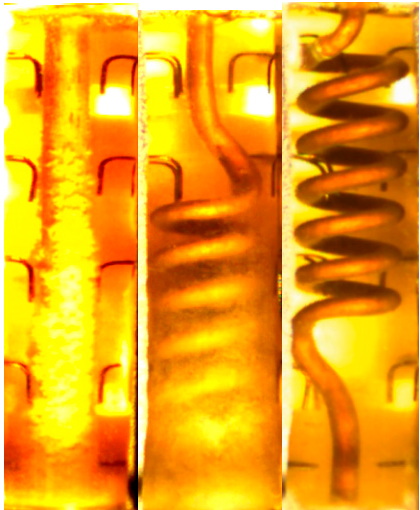
Figure 10. Solidification front images for different geometry of storage units but for the same process time equal to 10 min and the same constant wall temperature condition ( Ts = 17 °C): at left for annular TES, at the middle for shell-and-coil TES with coil position at the bottom of the tank, at the right for shell-and-coil TES with coil position at upper of the tank.